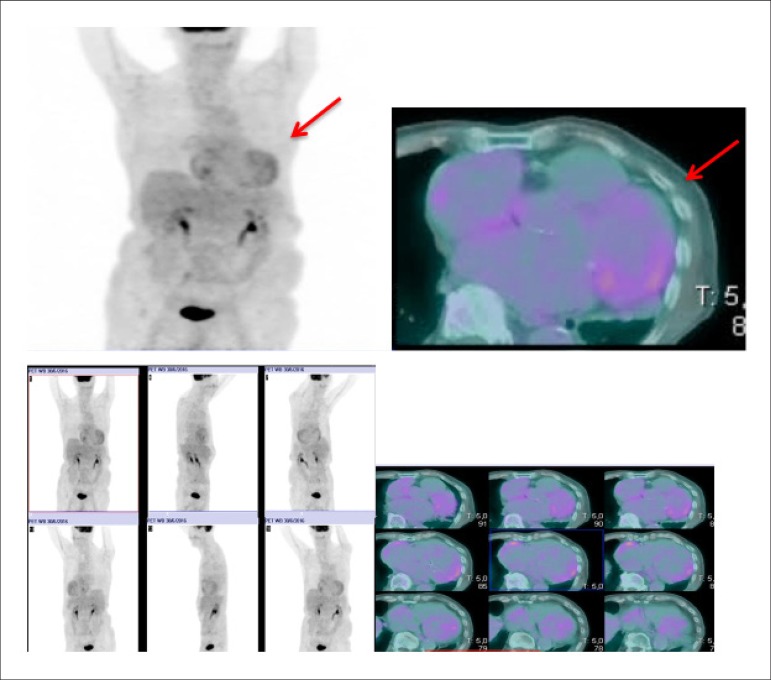
FDG-18F - PET/CT with suppression protocol for myocardial glucose uptake (diet), maximum-intensity-projection imaging (left) and coregistration with CT (right). Patient, age 88, with heart failure, reduced ejection fraction, and ventricular tachycardia. Endomyocardial biopsy was compatible with sarcoidosis. Images demonstrated abnormal tracer uptake in the right and left ventricles (arrows). Following immunosuppression, the patient showed clinical improvement and disappearance of abnormalities.